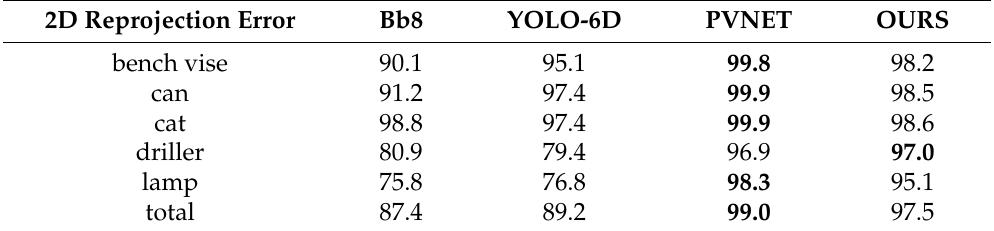
Table 7. Comparison with the state-of-the-art methods in terms of the 2D reprojection metric on LineMOD dataset. Bold number indicates the best